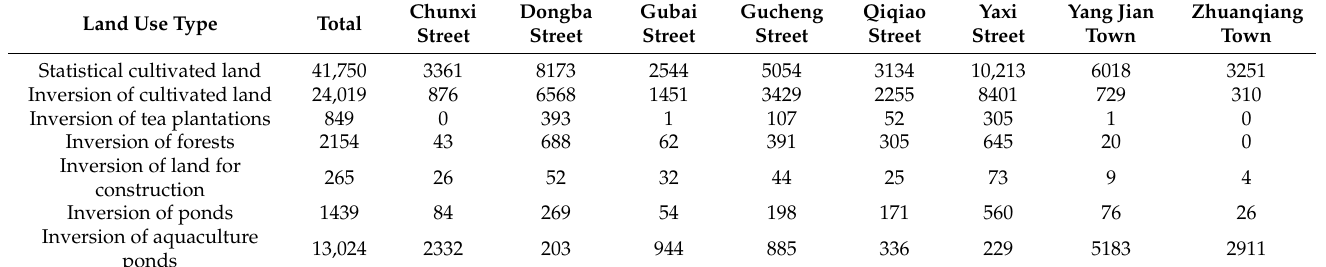
Table 5. Interpretation of cultivated land in Gaochun District. Unit: hectare.